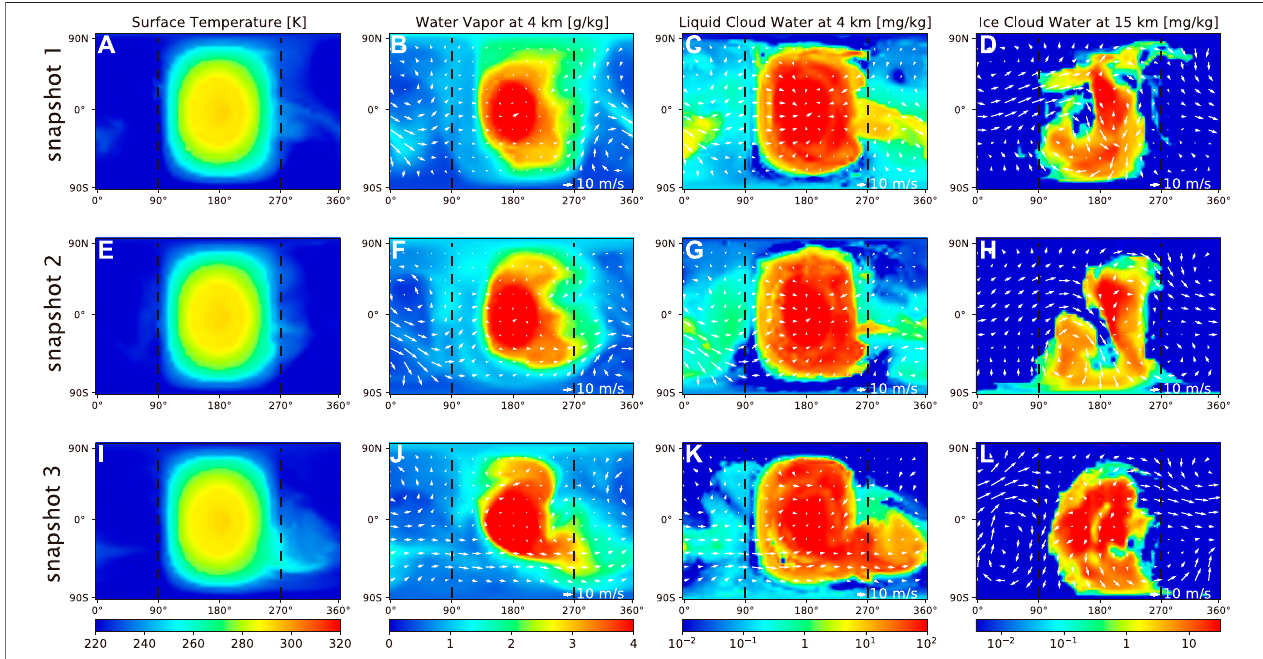
FIGURE6| Variabilityofthesystem:surfacetemperature(the fi rstcolumn),watervaporconcentrationat4 km(thesecondcolumn),liquidcloudwaterconcentrationat 4 km(thethird column), and ice cloud water concentration at15 km(thefourthcolumn)inthree different timesnapshots,for the slowlyrotatingplanetof60Earth days.The reference vector is 10 m s − 1 . Note that the color bars in the three right columns are different from those in Figure 4 . On this planet, the variability is still strong although the asymmetry between the morning and evening terminators is smaller than that on rapidly rotating planets in the transmission spectra (see Figure 2